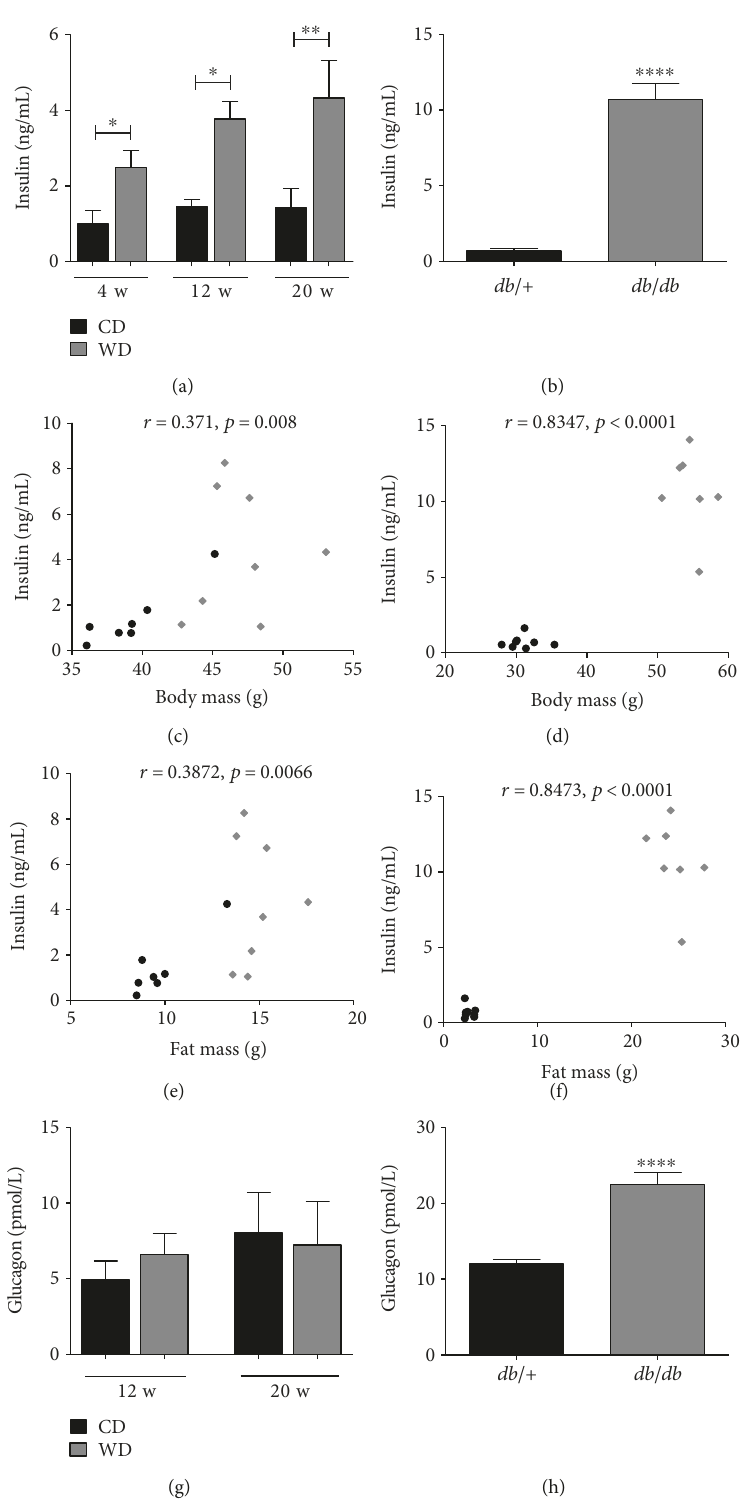
Figure 8: Circulating insulin levels are elevated in both mouse models of obesity, but glucagon is increased only in the db/db mice. Serum insulin (a, b) and glucagon (g, h) in C57BL/6J mice fed either control or Western diet for the indicated number of weeks (a, g) or 14- week-old db /+ and db/db mice (b, h). Serum insulin correlated to body mass or fat mass in C57BL/6J mice fed Western diet for 20 weeks (c and e, resp.) and in 14-week-old db/db mice (d and f, resp.) by Spearman ’ s correlation. n = 8 per group; means ± SEM; ∗∗∗∗ p < 0 0001 ; ∗∗ p < 0 01 ; ∗ p < 0 05 . CD: control diet; WD: Western